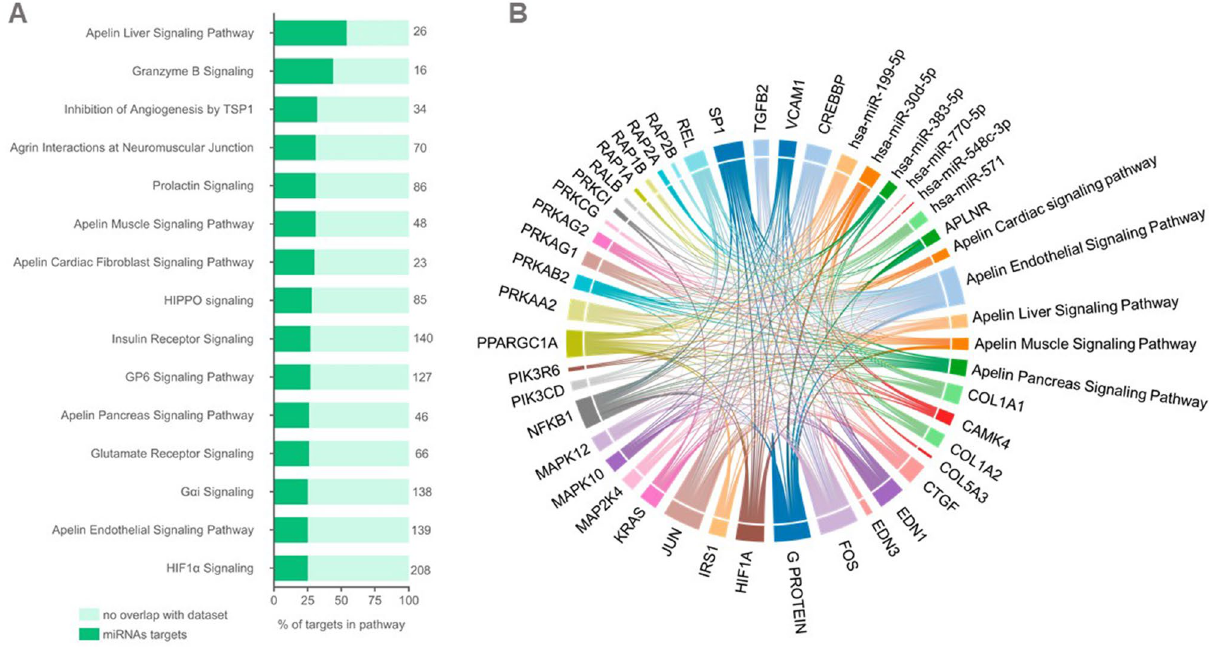
Figure 3. ( A ) Top 15 canonical pathways most significantly enriched represented as stacked bar charts. The total number of molecules within each pathway is at the top of each plotted bar. The log ( p -values) were Benjamini–Hochberg corrected with a cutoff of 1.3. The top enriched pathway was “Apelin Liver Signaling Pathway” with 14 out of 26 molecules within the pathway (53.8%) containing the higher number of targets of the dysregulated miRNAs. ( B ) Chord diagram representing the amount of connection between the four canonical pathways related to the Apelin Signaling Pathway: in the liver, endothelial, muscle/cardiomyocyte, cardiac fibroblasts, and pancreas, with several entities or nodes (gene/protein/miRNAs) within these pathways or indirectly connected with the pathway nodes. The more interrelatedness and connections the node has more relevant it is and also represented by different colors. The size was proportional to the number of connections. In this particular diagram, the colors of the chords partially mixed with the colors of their connected